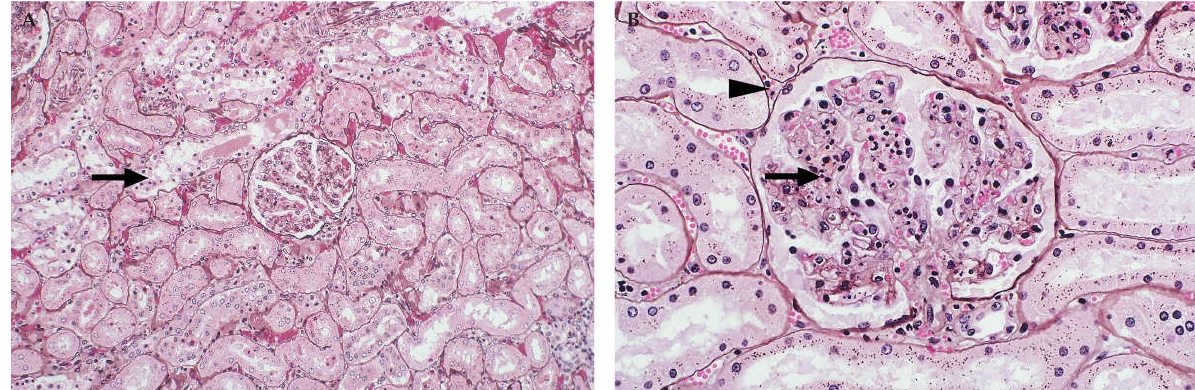
Figure 6. Kidney of RVFV-infected adult sheep (Jones’ methenamine silver stain). ( A ) Lesions in necrotic tubules are characterized by tubular epithelial cell pyknosis, karyorrhexis, and karyolysis accompanied by detachment of the epithelium from the basement membrane (arrow), mag 200×. ( B ) Pyknosis and karyorrhexis are present in a renal glomerulus (arrow) with a marked decrease in mesangial cellularity. Pyknosis is also present in the interstitium (arrowhead) and in many tubular epithelial cells, mag 400×.